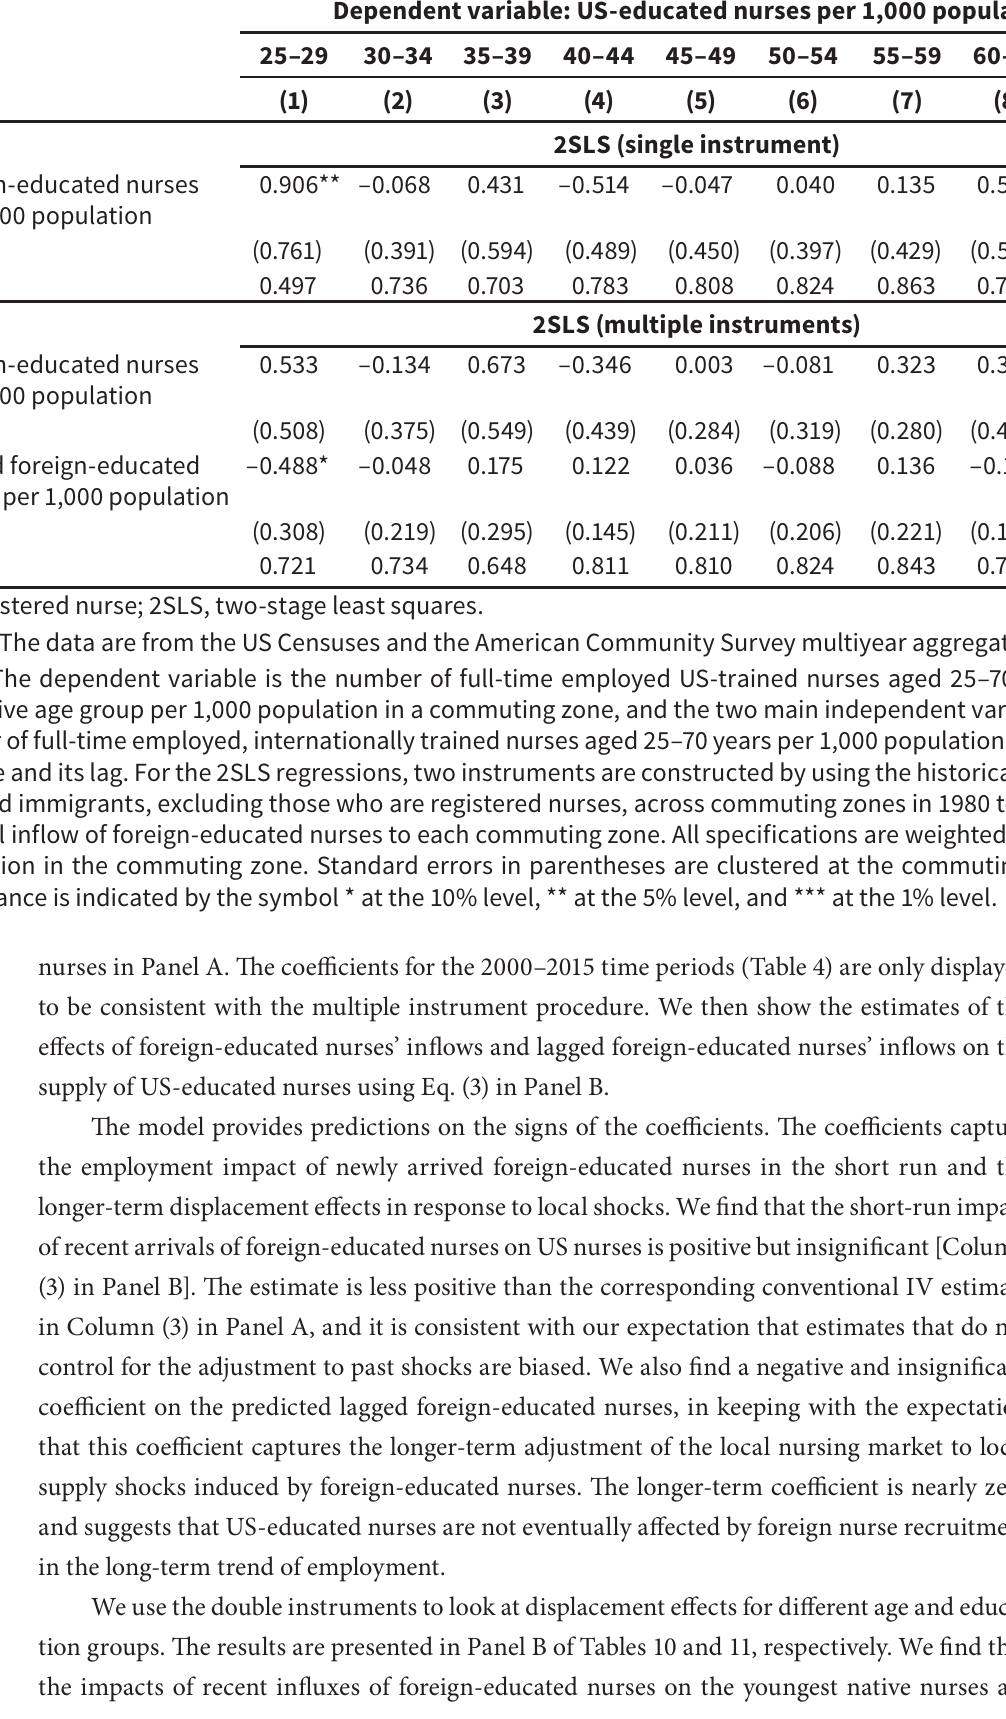
Displacement effects of foreign-educated RNs on US-trained RNs by age, 2000–2015 Dependent variable: US-educated nurses per 1,000